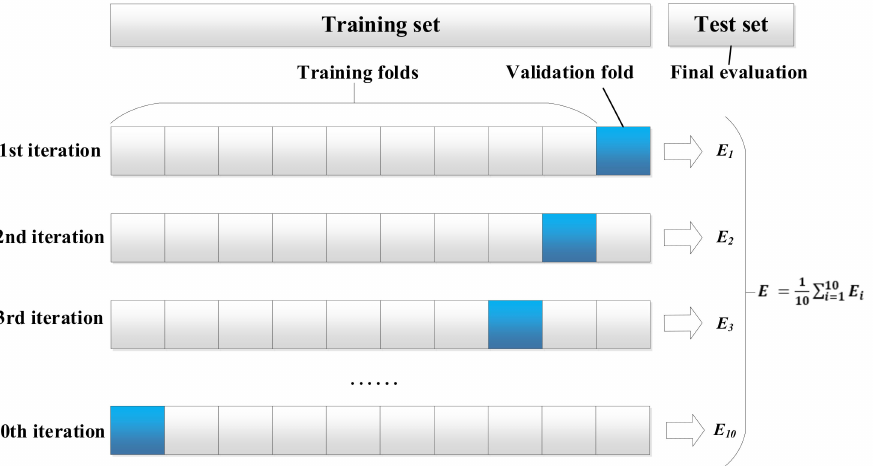
Figure 4. 10-fold cross-validation and test set evaluation methods. E represent the results of the regression evaluation criteria such as EVS, MAE, MSE, RMSE, MedAE,